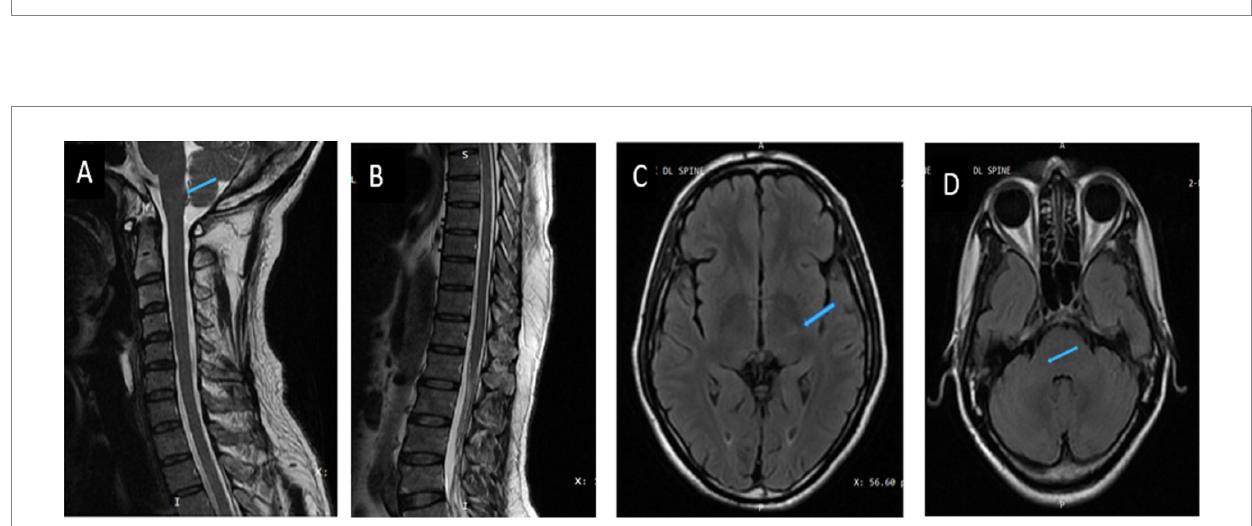
FIGURE 1 Pretreatment MRI cervicodorsal spine and brain image of the patient. (A,B) Sagittal T2/STIR images of the cervicodorsal MRI showed longitudinal extensive T2 hyperintensity in C5-D11 spinal cord segment (yellow bracket) along with brainstem involvement (yellow arrow). (C,D) Axial T2/STIR and T1 Contrast image of dorsal spine showing T2hyperintensity and partial enhancement, respectively, (Yellow arrow). (E,F) Axial FLAIR images how multiple hypointense lesions with surrounding hyperintensity in the left thalamus and the right mesial temporal and middle cerebellar peduncle suggestive of cryptococcal encephalitis (Yellow